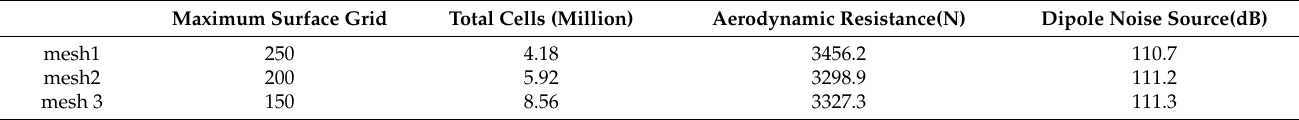
Table 2. Grid-independence